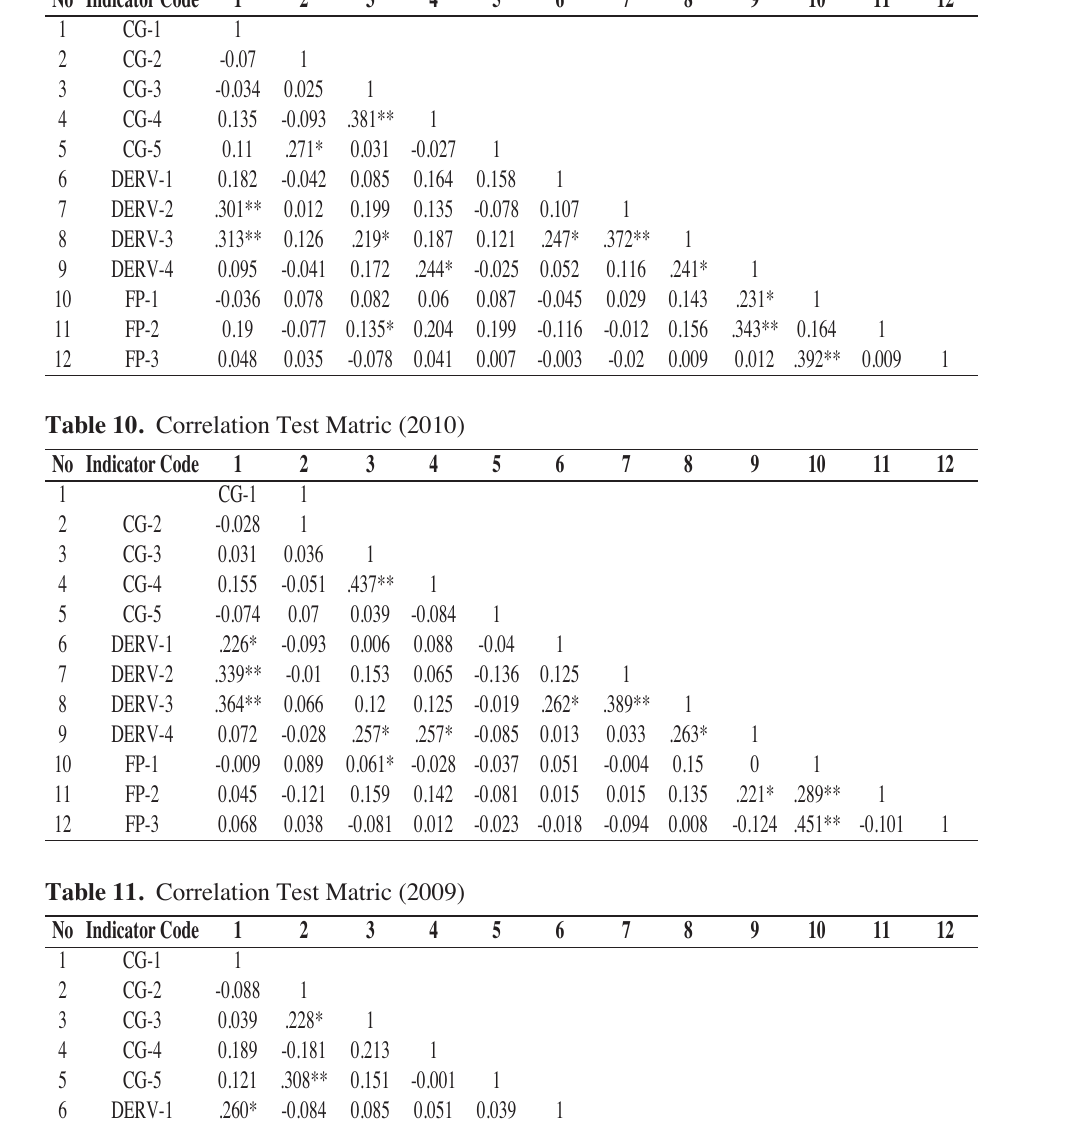
Table 9. Correlation Test Matric (2011)